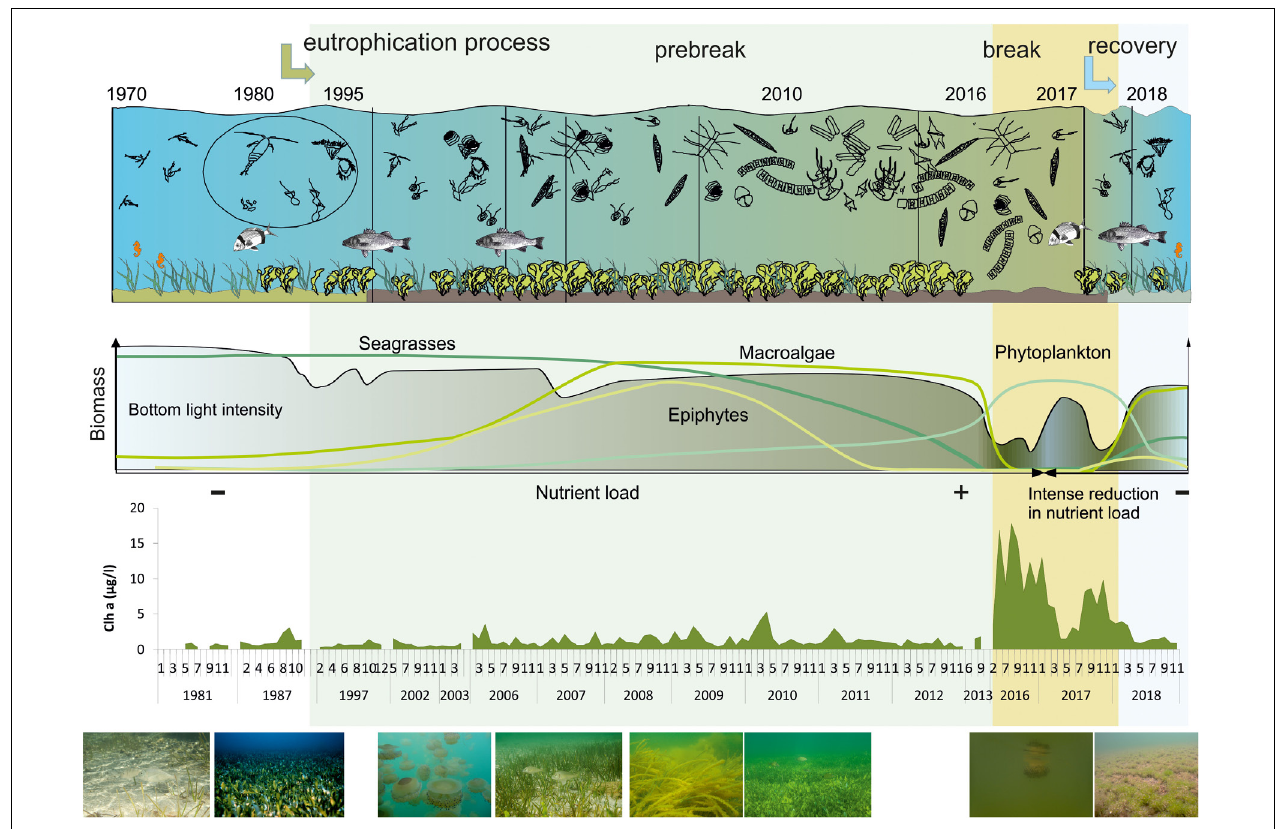
FIGURE 10 | Synthesis of the evolution of the three phases of the eutrophication process in the Mar Menor lagoon and main changes occurred in the system during